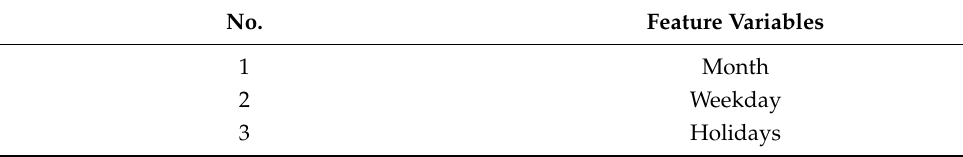
Table 3. Feature variables in the time dimension.